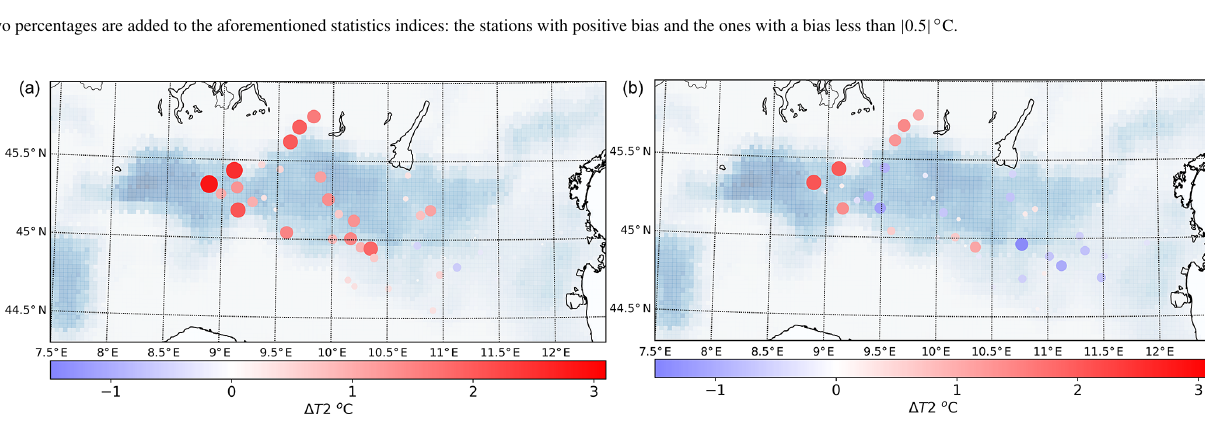
Figure 5. Monthly average for the 2m mean temperature differences between the control (a) or channel (option 1, b ) run and the weather stations at their locations. This is for July 2015 from the 3-month simulation (LR2). Both dot size and color represent the bias, and they are used combined to highlight high